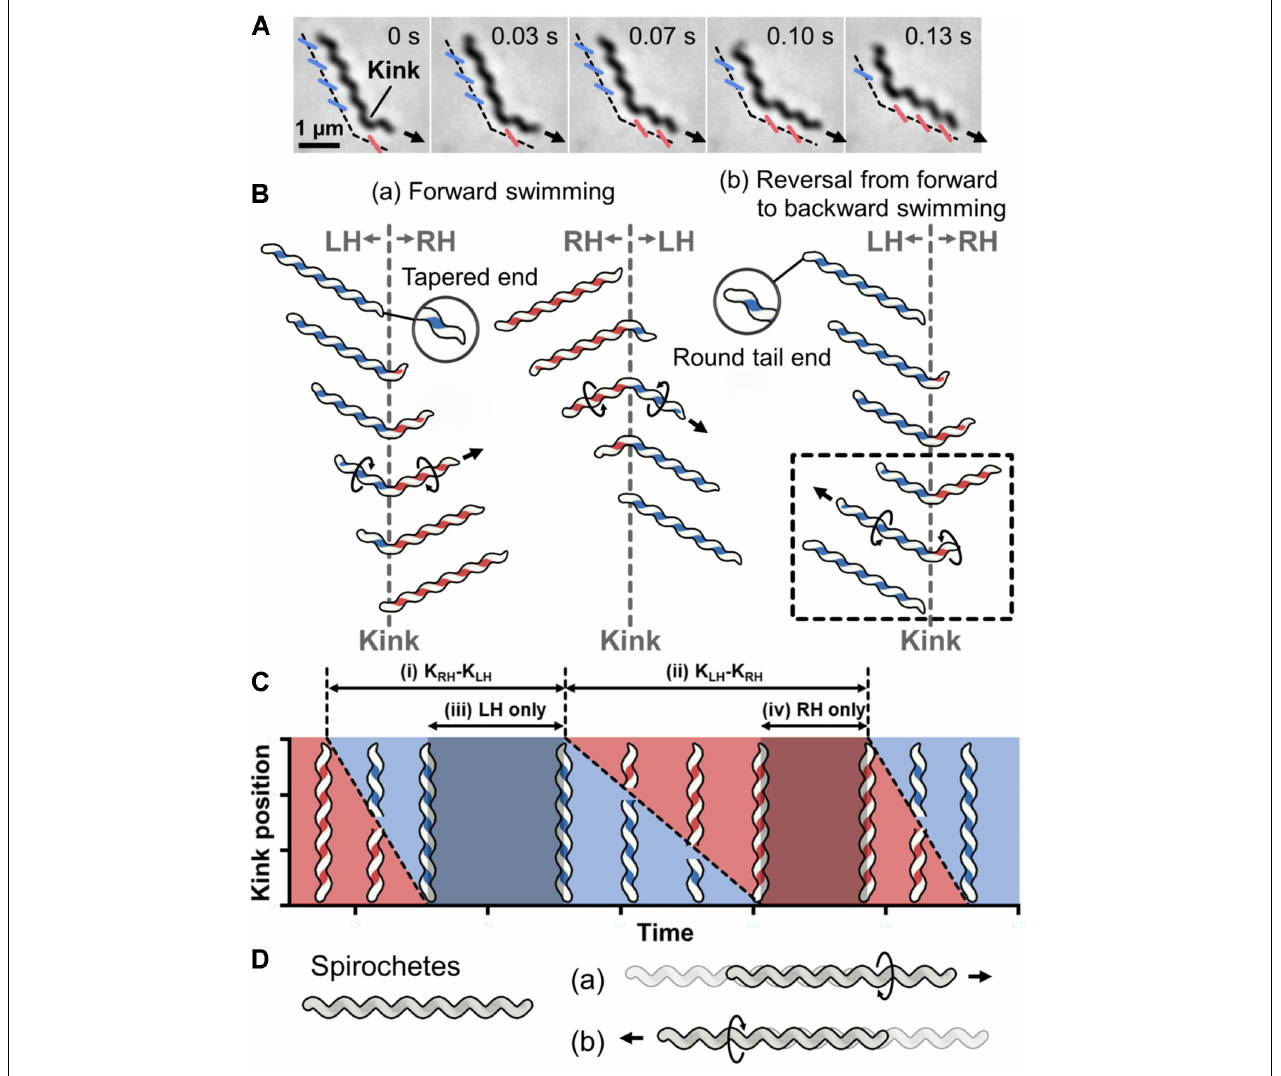
FIGURE 1 | Helicity-switching swimming of Spiroplasma . (A) Phase-contrast microscopy of swimming cell. The blue and red lines indicate the left- and right-handedness (LH and RH) of the helical cell morphology, respectively. The swimming direction is indicated by the arrow. Time is shown in seconds at the upper right of each panel. (B) Swimming schematics. A kink is formed at the boundary of the different handedness. Counter-rotational torque is generated backward and forward of the kink position as shown by circular arrows. (a) The cell basically swims in the direction of the tapered end. (b) Sometimes cells reverse the direction of kink traveling, resulting in swimming reversal. The reversal kink traveling is presented in the dashed box. (C) Schematic diagram of kink position as it travels along the whole cell length during swimming. The time when the cell helix keeps LH and RH is colored blue and red, respectively. The intervals of the kink productions are indicated by (i) and (ii). The time when the cell keeps the body as LH and RH is marked as (iii) and (iv), respectively. This is a schematic presentation of previous data (Nakane et al., 2020). (D) Schematic for Spirochetes swimming. The helical cell has the same handedness throughout the whole cell length. The cell swims forward by rotating the cell helix in one direction (a) or backward after switching the rotational direction